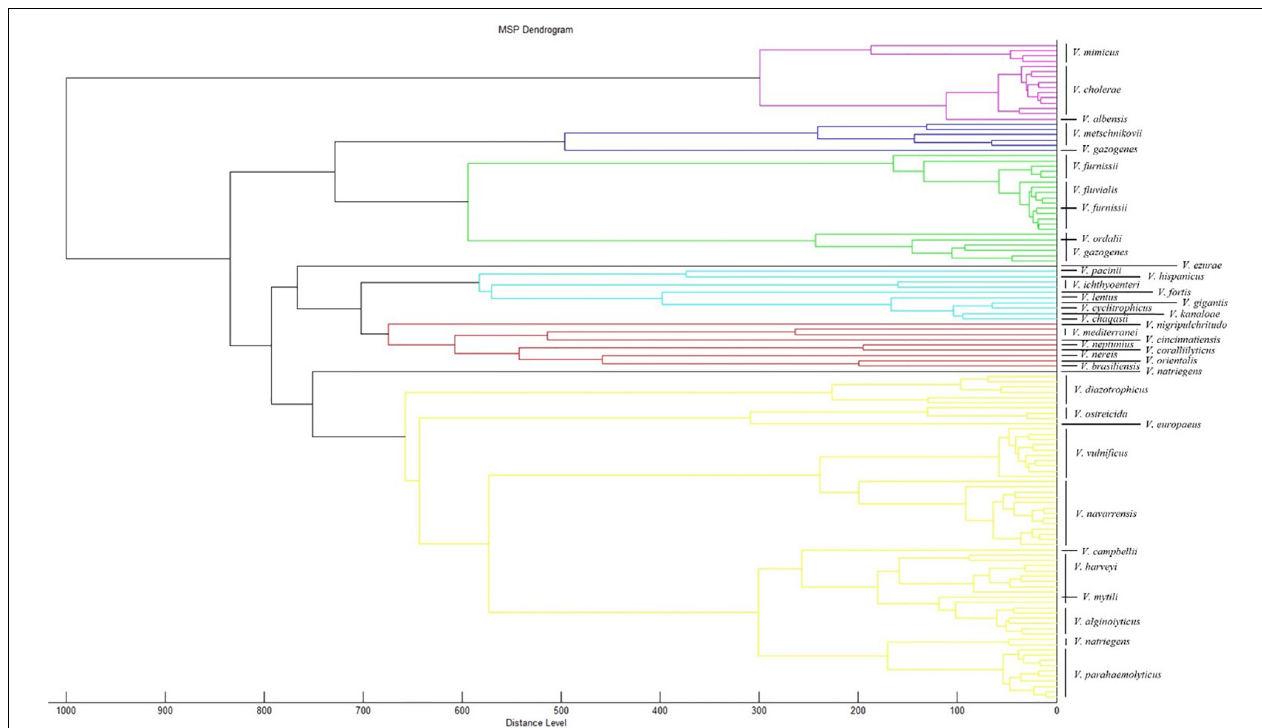
FIGURE 5 | Dendrogram analysis of different Vibrio species. 77 strains of all Vibrio species were randomly selected from PVBase and 48 strains of all Vibrio species were randomly selected from Bruker MBT library. The dendrogram analysis was performed using MALDI BioTyper Compass Explorer v.